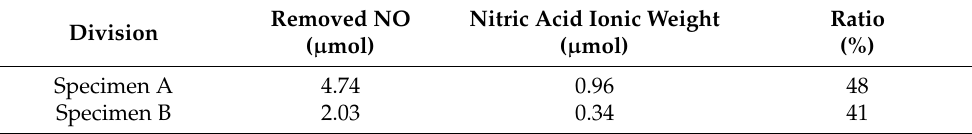
Table 5. NO removal for each specimen, nitric acid ion weight and ratio analysis results.